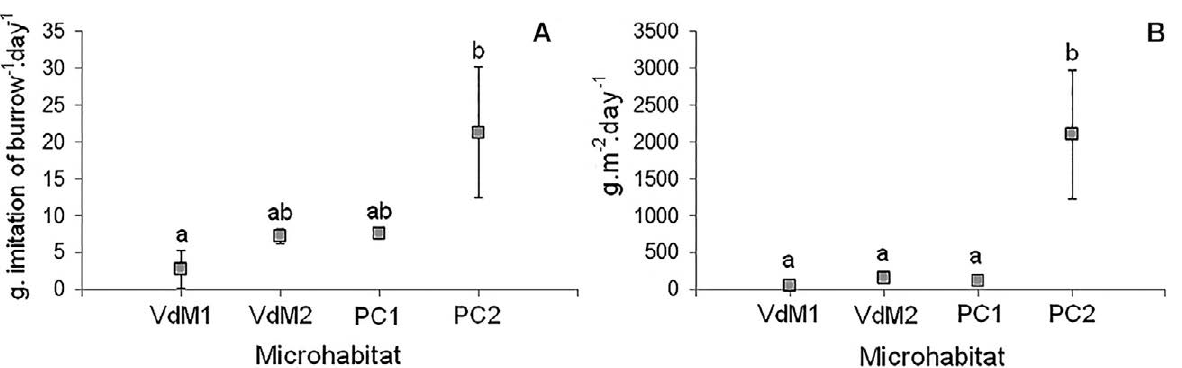
Fig. 6. – Daily dry sediment entrapment. A, of an individual burrow. B, in 1 m 2 , in the different microhabitats. Mean and standard deviation are shown. Tukey test (same letters indicate that there are no significant differences, α